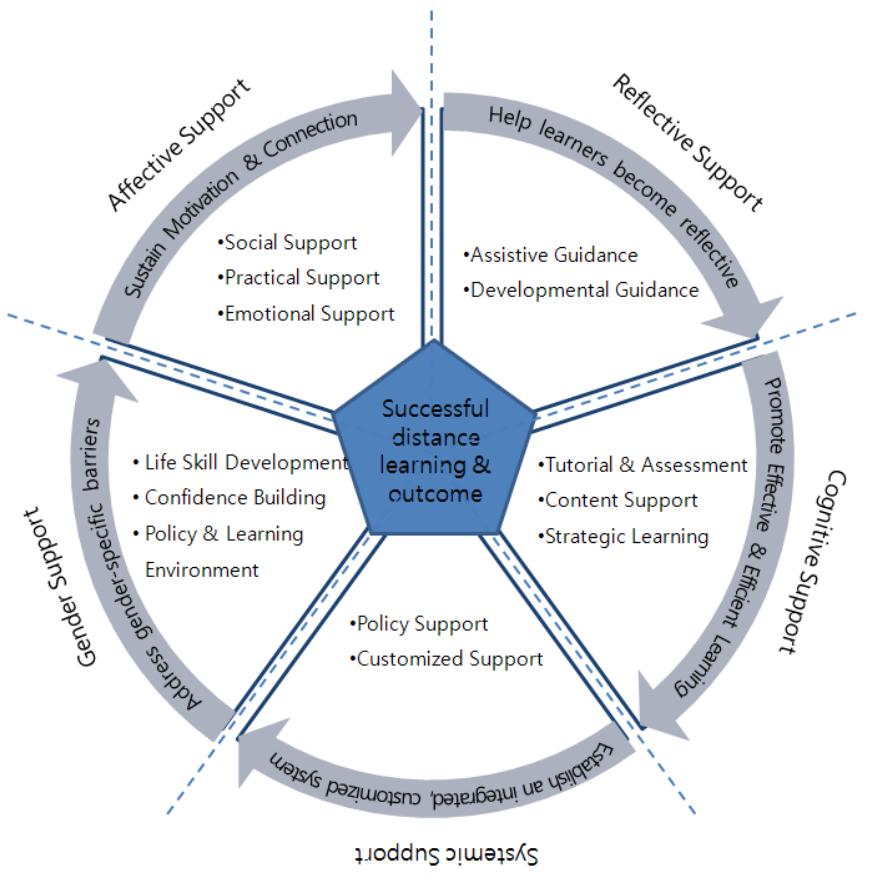
Figure 1. A model of systemic student support for Asian distance